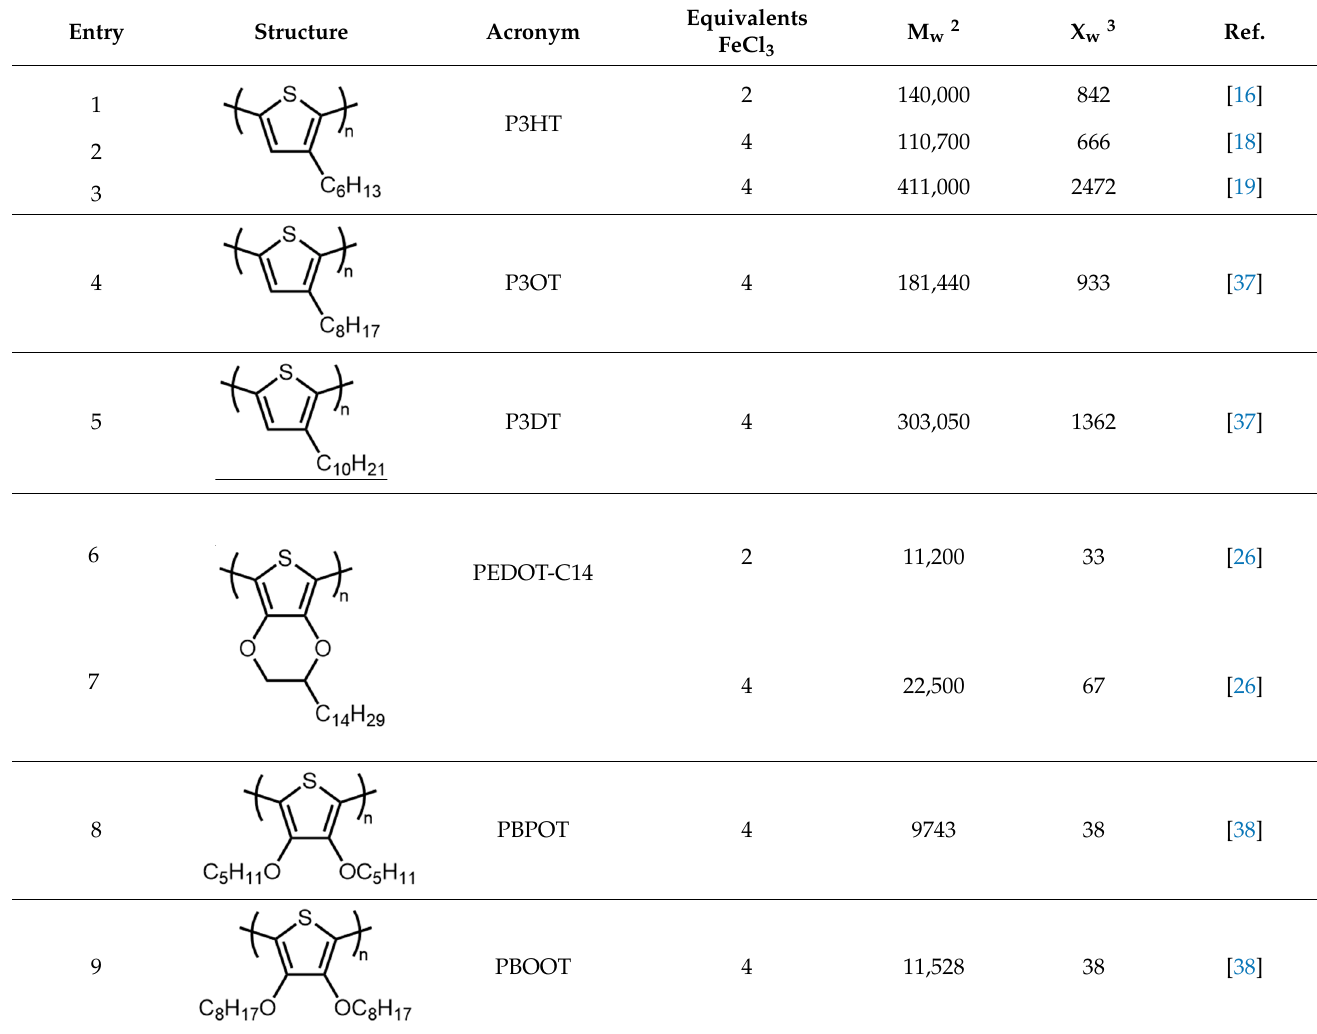
Table 1. Previously reported molecular weight data of P3HT and relevant alkyl and ether-substituted polythiophenes synthesized by FeCl 3 -initiated oxidative polymerization 1 .